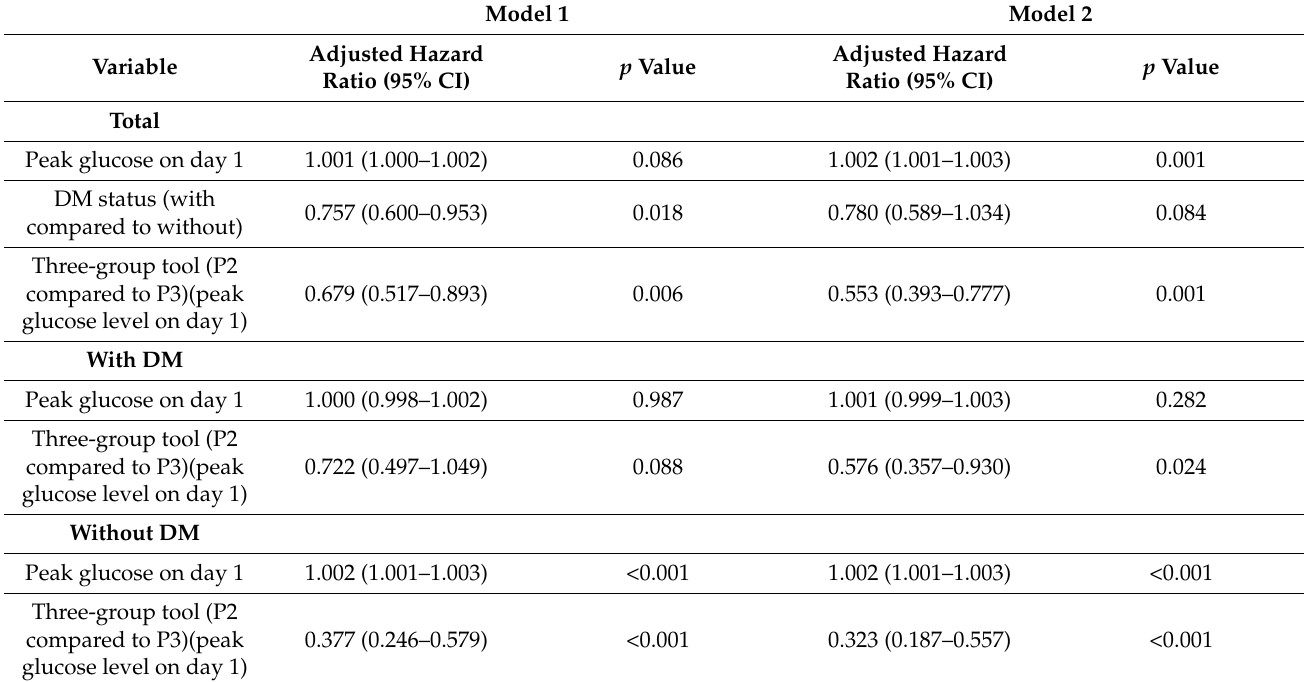
Table 3. Cox proportional-hazards regression analysis for 90-day mortality (adjusted HR) in construction cohort.